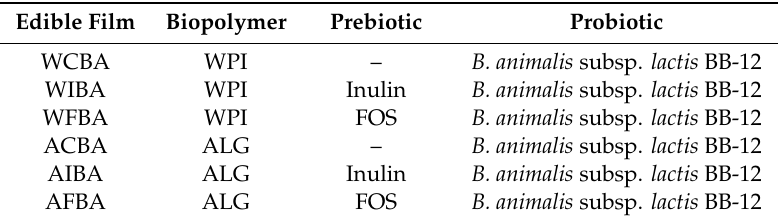
Table 1. Compositional aspects of the film forming